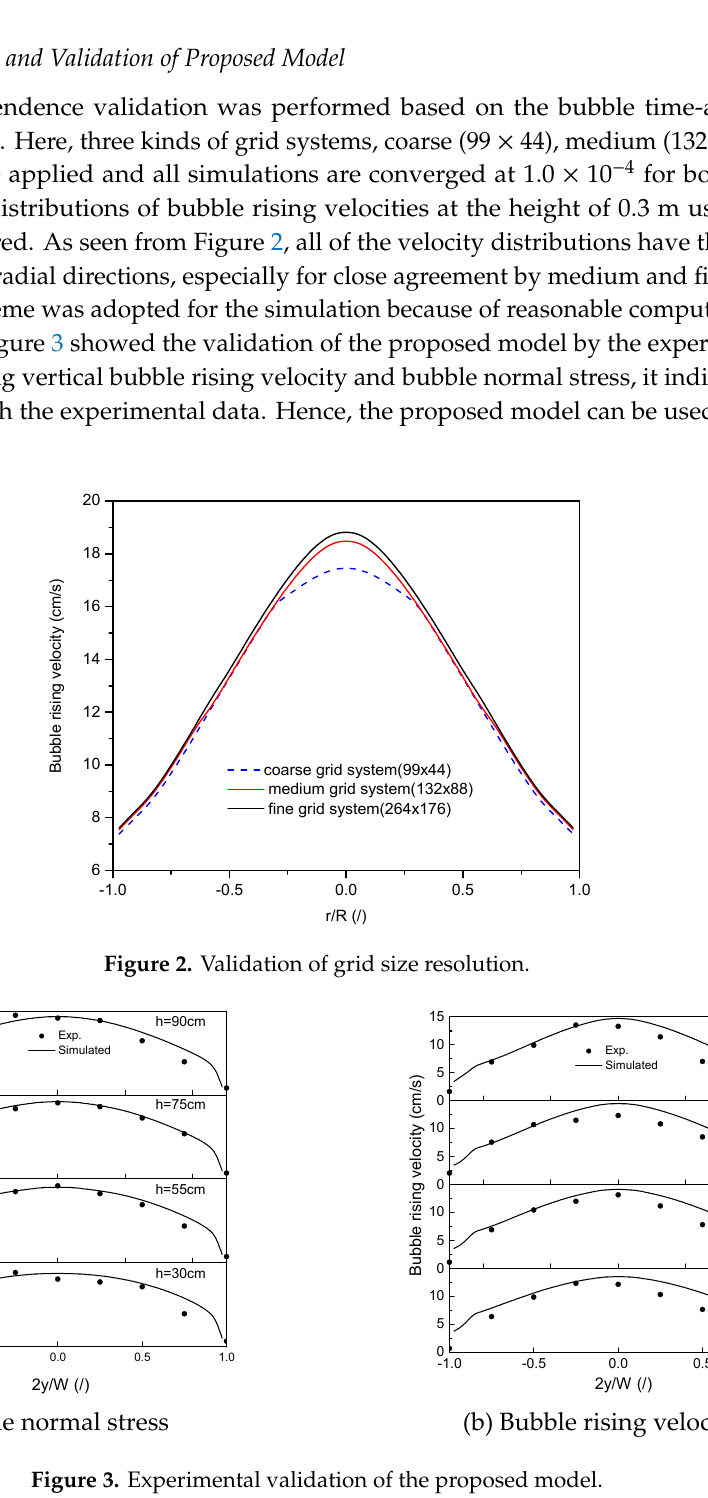
Figure 1. 2-D schematic of the sparged bioreactor in this simulation.